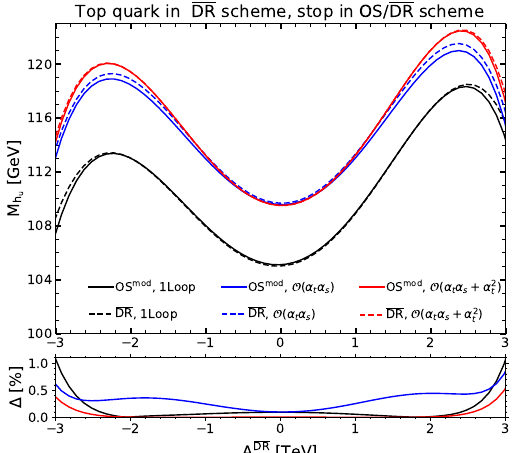
Figure 13 . Upper Panel: the mass of the h u -like Higgs boson at one-loop level (black/two lower lines) and at two-loop level including the O ( (cid:11) t (cid:11) s ) corrections (blue) and the O ( (cid:11) t (cid:11) s + (cid:11) 2 tions (red) as a function of A DR . Solid lines: modi(cid:12)ed OS, dashed lines: DR renormalization in the t top/stop sector. Lower Panel: absolute value of the relative deviation of the result with modi(cid:12)ed OS renormalization in the top and stop sector with respect to the result using a DR scheme in percent at one-loop (black), two-loop O ( (cid:11) t (cid:11) s ) (blue) and at two-loop O ( (cid:11) t (cid:11) s + (cid:11) 2